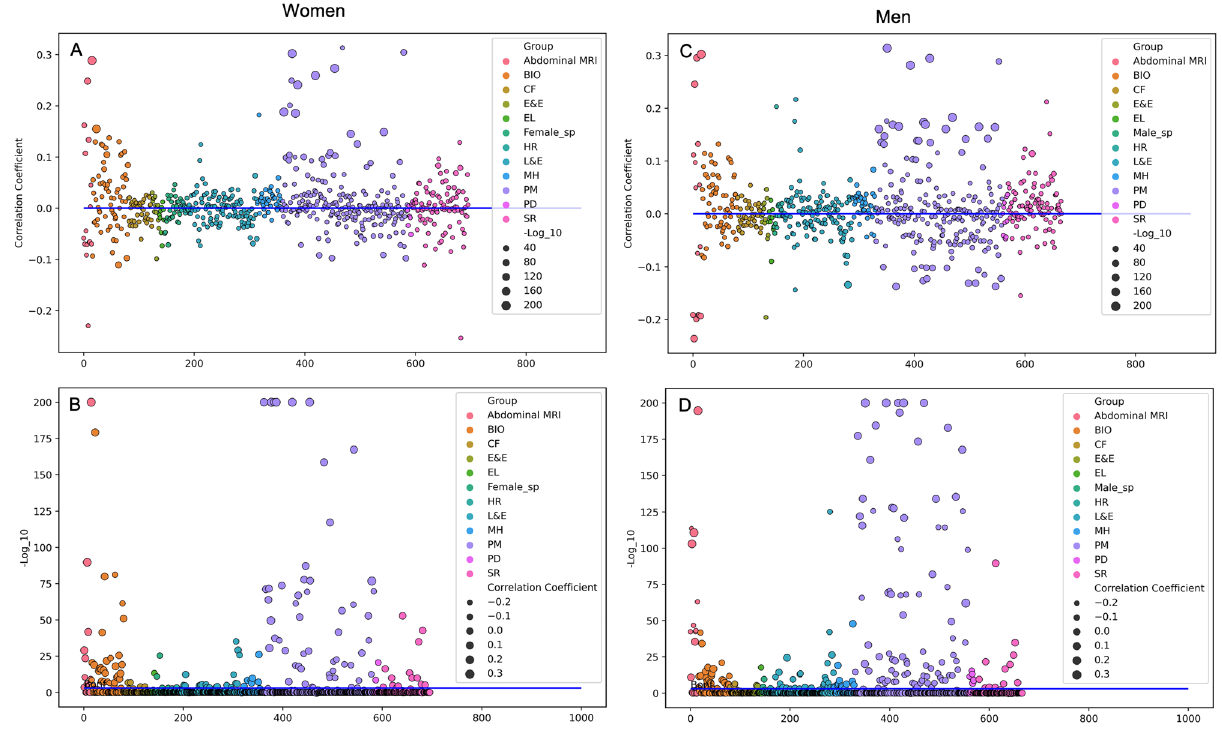
Figure 3. Results from the phenome wide association study. Associations of exposures recorded in UK Biobank with heart age delta expressed using Pearson correlation coefficient with corrected p-value (− log10). Each circle represents an individual exposure. In ( A and C ), correlation coefficient is shown on the y-axis and the magnitude of p-value is represented by the size of the circles (larger circles indicate more significant (p-value * number of tests < 0.05) results). ( B and D ) have − log10 corrected p-value on the y-axis, thus distance from the line represents significance level and size of the circles represents magnitude of the correlation.